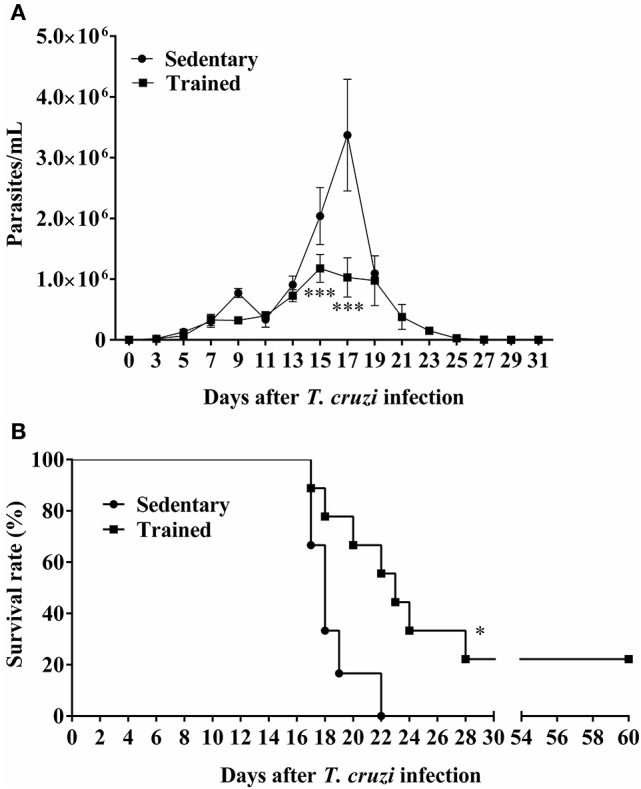
Effect of treadmill exercises on the course of T. cruzi infection in mice. Parasitemia and survival were determined in Swiss mice infected with 5 × 103 blood trypomastigotes T. cruzi (Y strain) 2 days after the end of the physical activity protocol. (A) Parasitemia was quantified as trypomastigotes per milliliter of blood. The data (mean ± SEM) are representative of two independent experiments. ***P < 0.001 comparing trained vs. sedentary mice. (B) Survival rate was determined by Gehan-Breslow-Wilcoxon test. The number of animals of the experimental groups was 9 trained and 6 sedentary. *P < 0.05 comparing trained mice with sedentary mice.